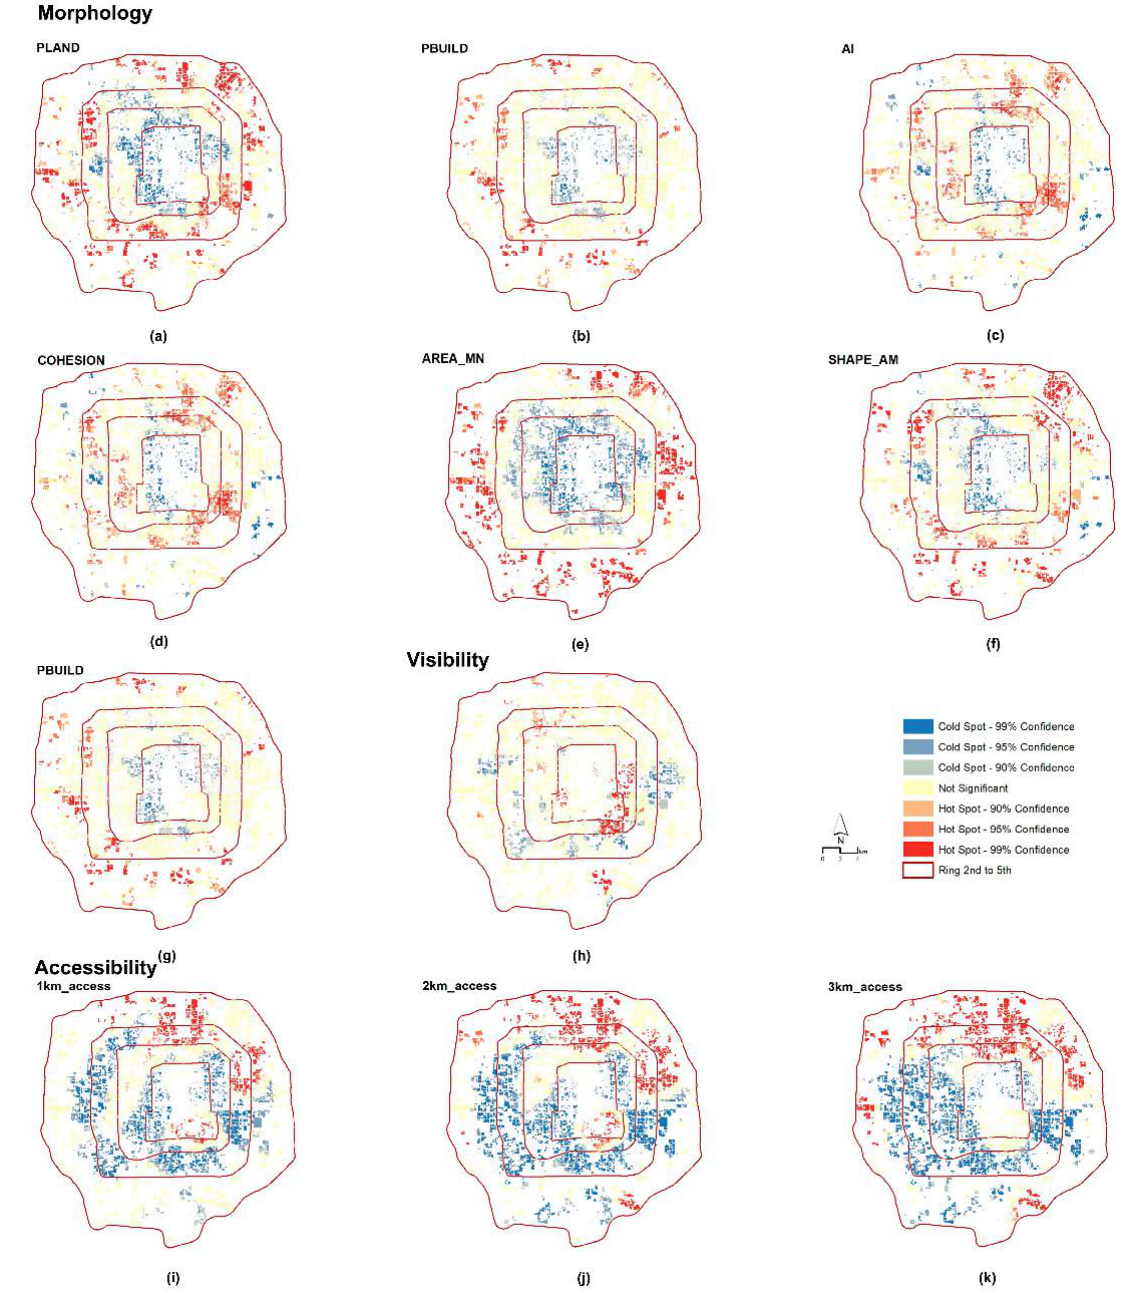
Figure 5. Spatial clusters of 11 green inequity metrics, in terms of morphology ( a – f ), visibility ( g , h ) and accessibility ( i – k ). Areas with good and poor green space conditions (i.e., hot and cold spots) reflects protective and harmful effects on humans,